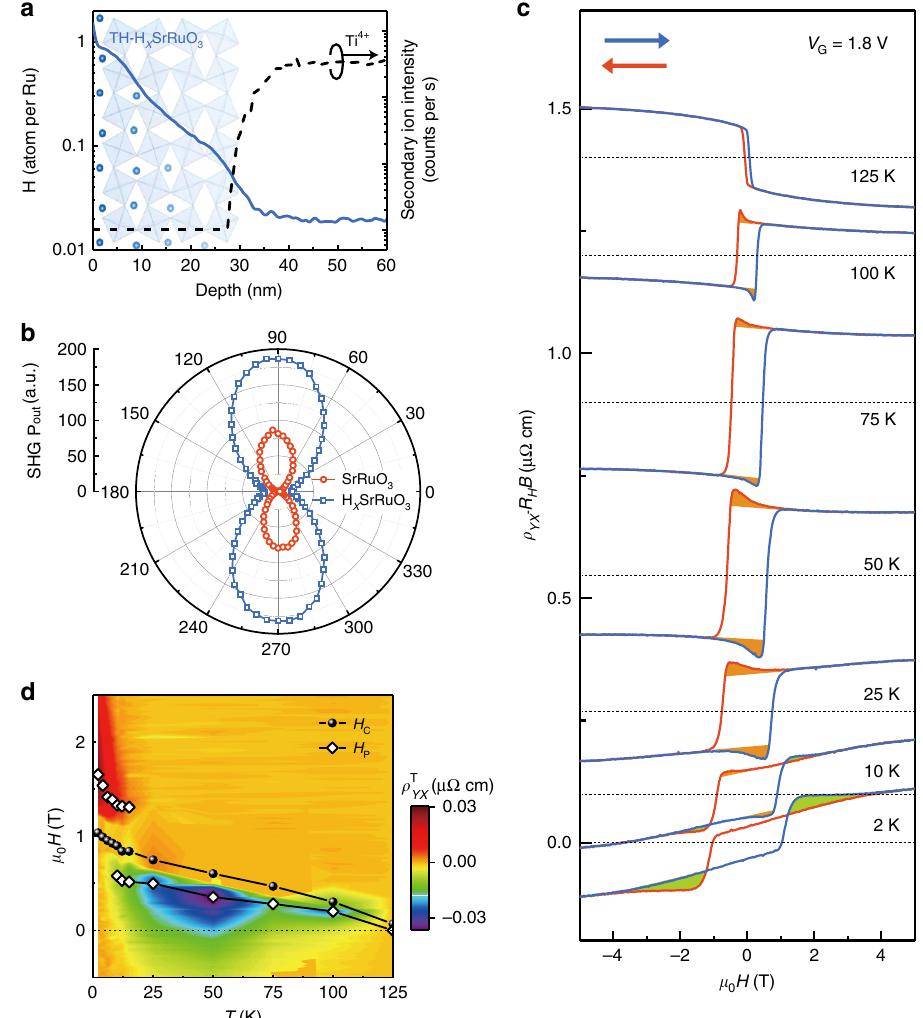
Fig. 4 Emergence of topological Hall effect in H x SrRuO 3 . a Ex-situ measured proton distribution pro fi le in a sample (~32 nm) with topological Hall effect. b P-polarized SHG intensity as a function of the polarization direction of the incident light (0 corresponds to s-polarization) for both pristine SrRuO 3 and gated H x SrRuO 3 fi lms. The weaker SHG in the pristine fi lm is due to surface contributions, while the enhanced SHG intensity of the H x SrRuO 3 state suggests the breaking of inversion symmetry in bulk. c Magnetic fi eld dependent Hall resistivity for H x SrRuO 3 gated with V G = 1.8 V at different temperatures. The blue and red arrows denote the fi eld sweeping direction. Ordinary Hall term is subtracted through the linear fi tting of R H B at higher magnetic fi elds. An offset is applied per curve for clarity, while the dotted lines denote the center of the hysteresis loops. The estimated topological Hall (cid:1) (cid:3) resistivity with different signs is marked with different colors. d Color map of estimated topological hall resistivity ρ T YX and characteristic fi elds ( H C and H V = 1.8 V. H fi lled symbol) represents the coercive fi eld and the H fi eld P ) obtained at H x SrRuO 3 gated with G C (black P (white open diamond) denotes the where the topological Hall resistivity reaches its